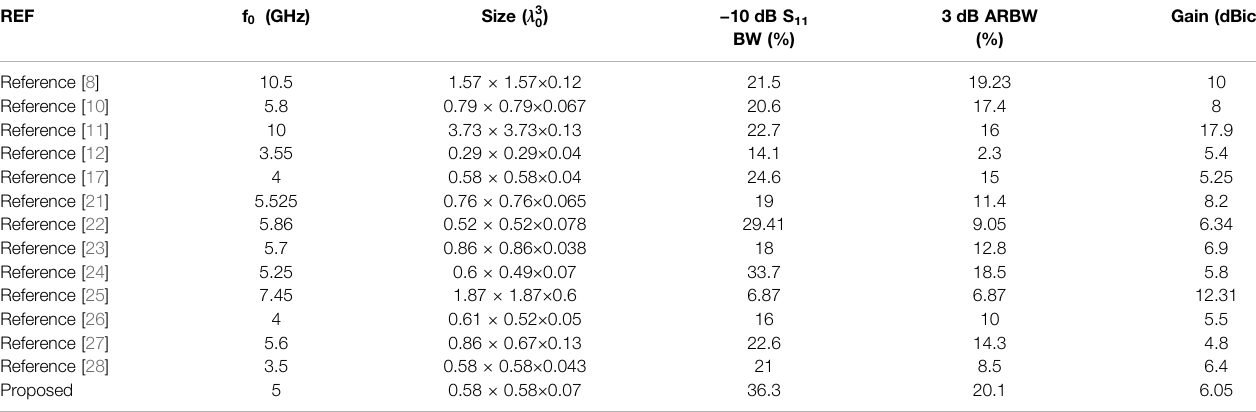
TABLE 2 | Comparison of the performance of recently reported CP metasurface